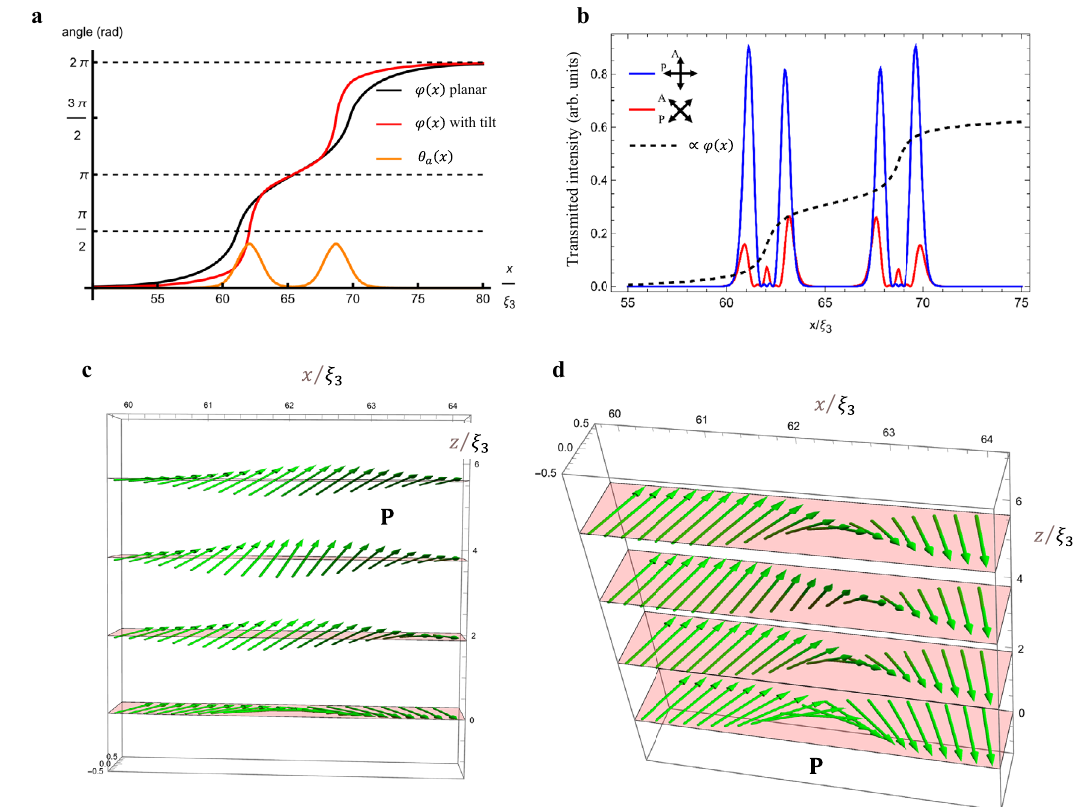
; 3 π . b Transmitted light 2 2 ¼ π . Note the favorable 2 λ ; 3 π ; 5 π ; 7 π . c , d Two projected schemes of 4 4 4 4